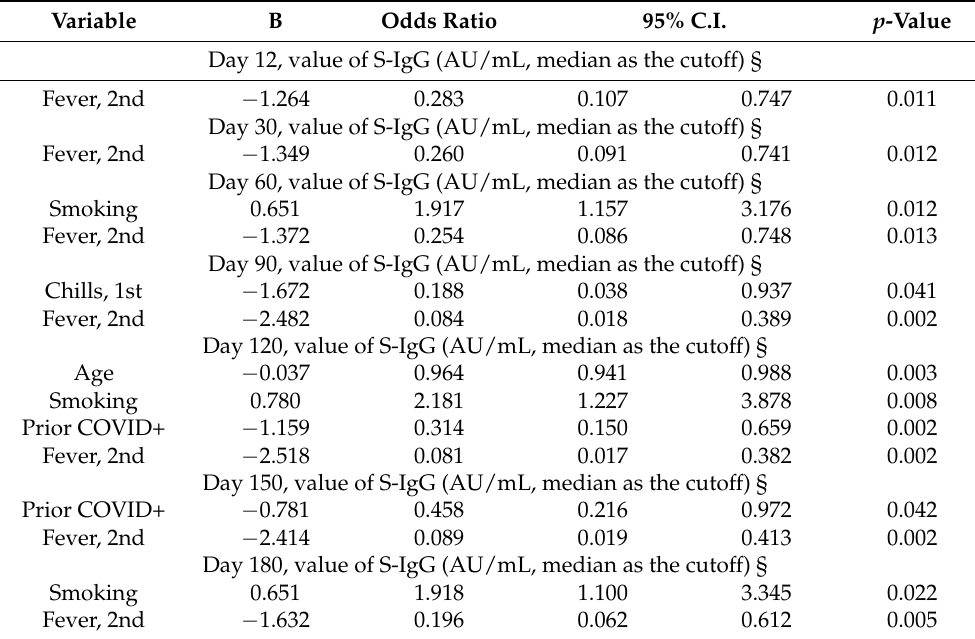
Table 2. Serial associations among level of S-IgG, adverse events after vaccination and demographic- clinical variables at seven time points (Day 12, Day 30, Day 60, Day 90, Day 120, Day 150, and